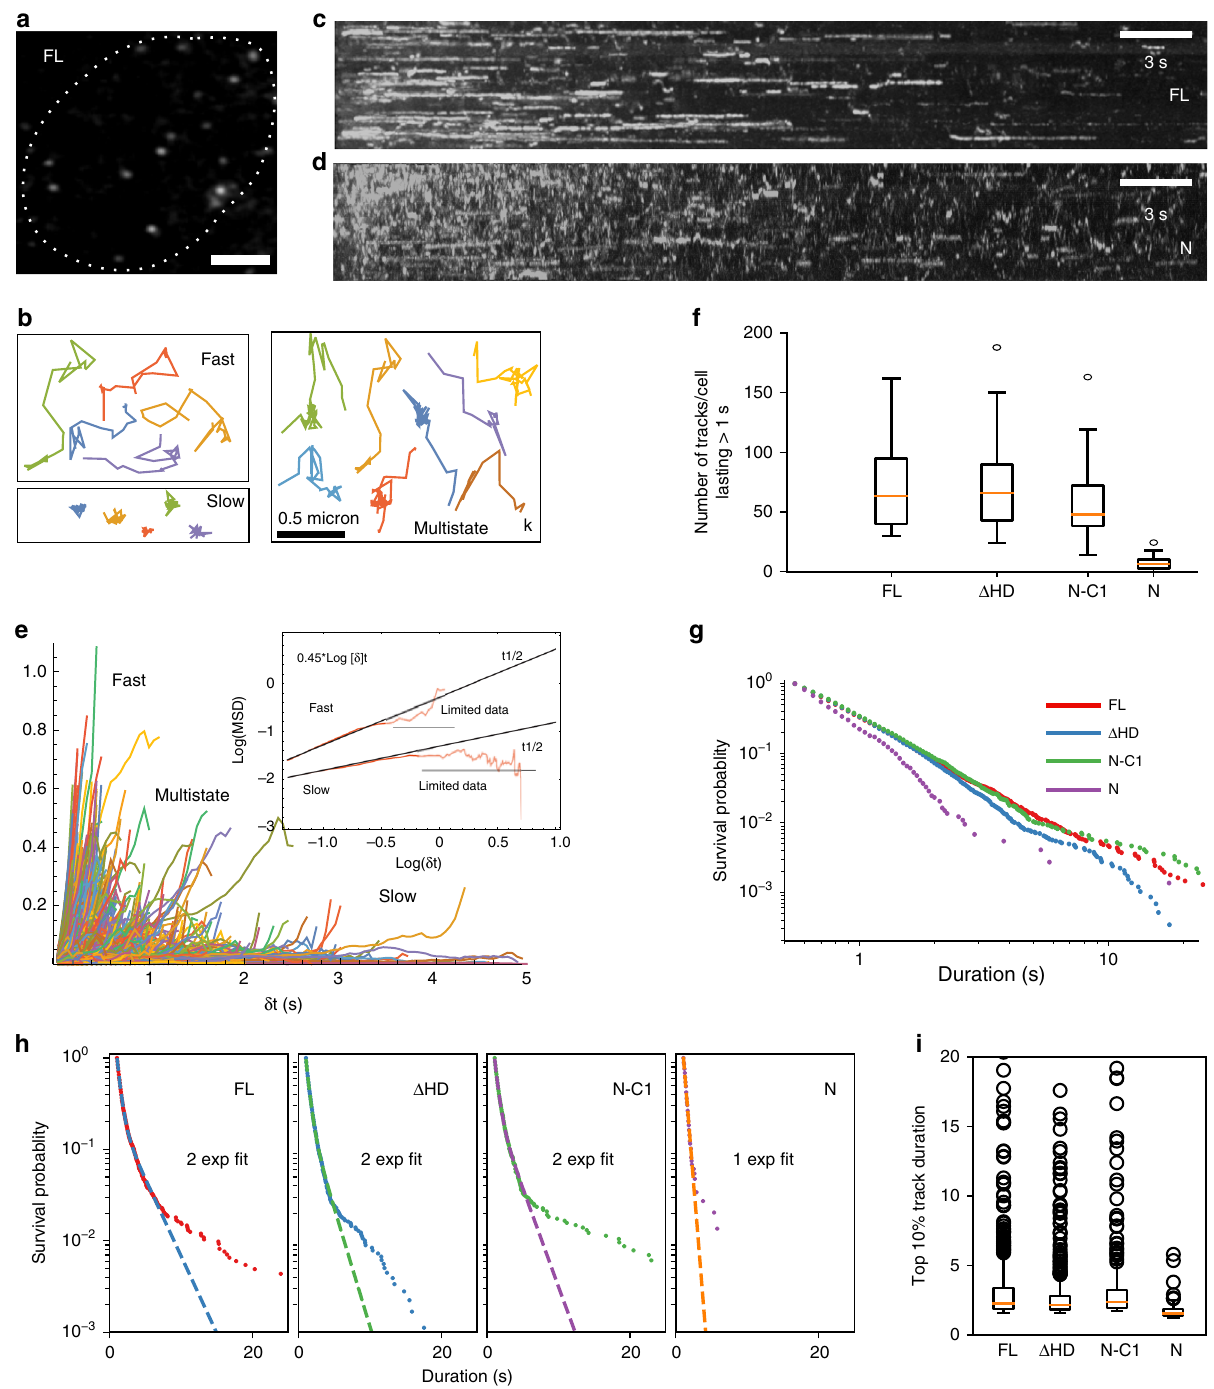
Fig. 7 Single molecule tracking analysis of Satb1. a A Hilo TIRF image of an MCF-10A cell showing single Satb1-eGFP molecules (Scale bar is 5 µ